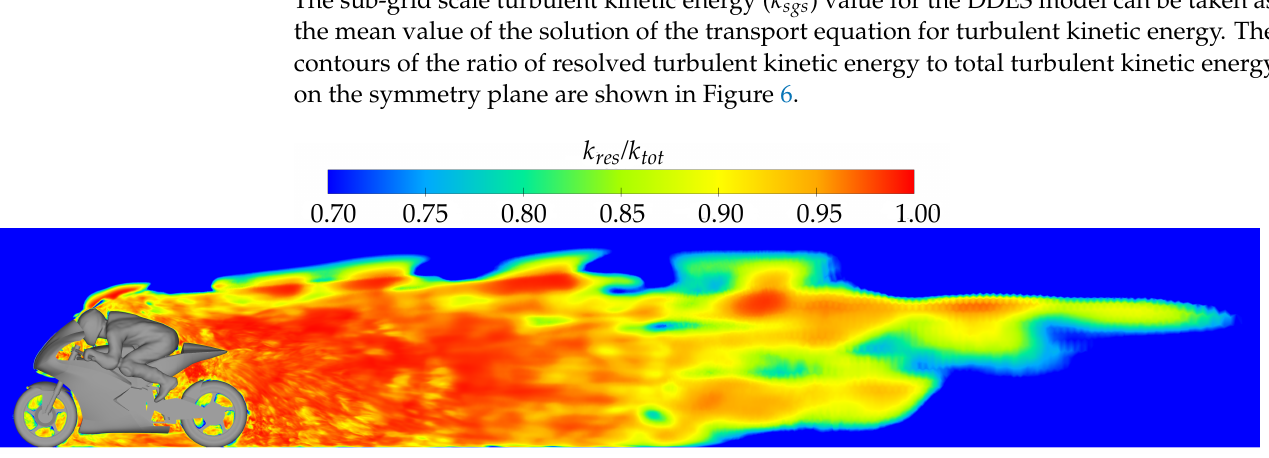
Figure 6. Contours of the ratio of resolved turbulent kinetic energy to total turbulent kinetic energy on the symmetry plane.